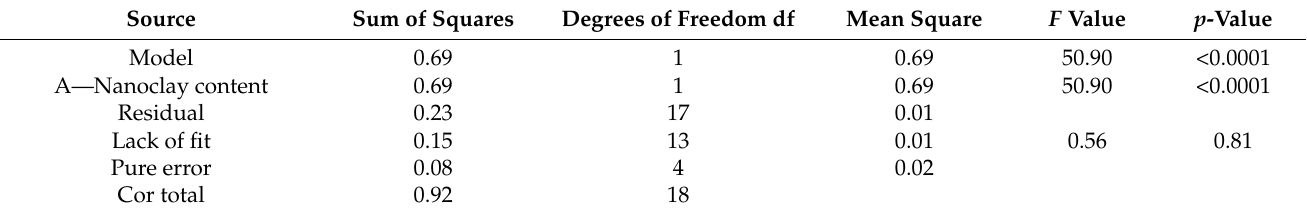
Table 7. Analysis of variance for the reduced linear regression model: flexural